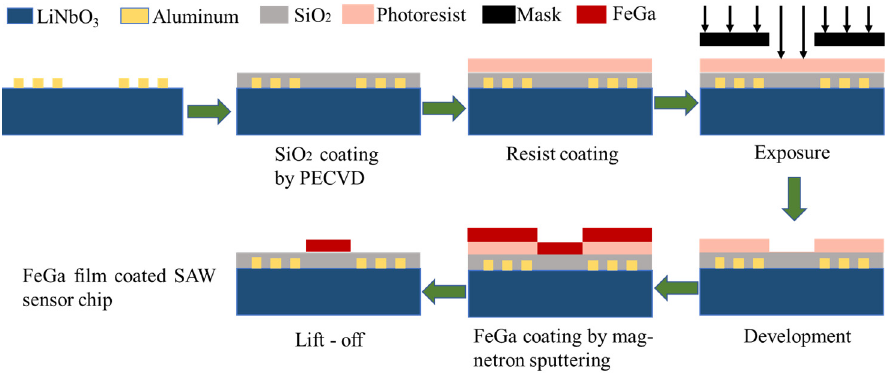
Figure 4. The fabrication process of FeGa film.